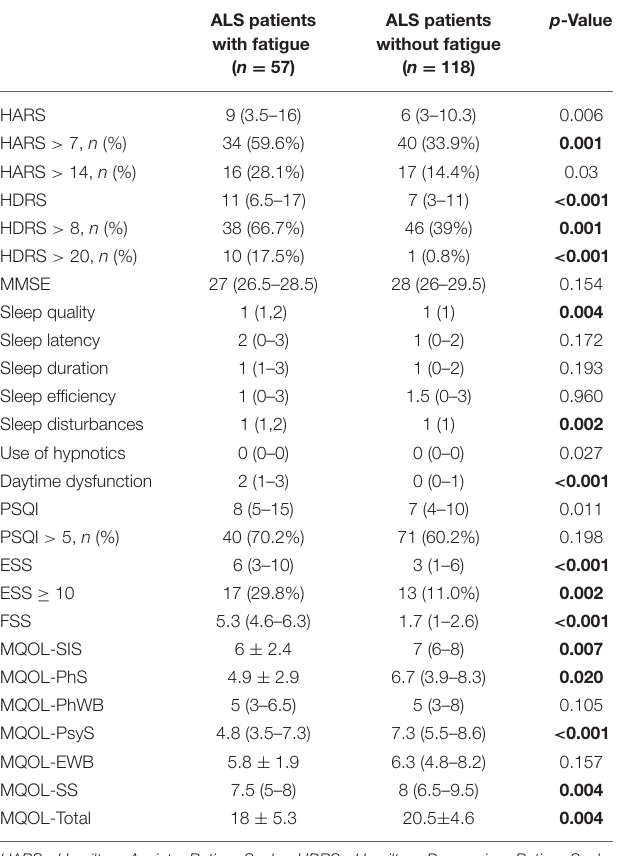
TABLE 4 | Factors associated with the presence of fatigue in the binary logistic regression analysis. p -Value Covariates B